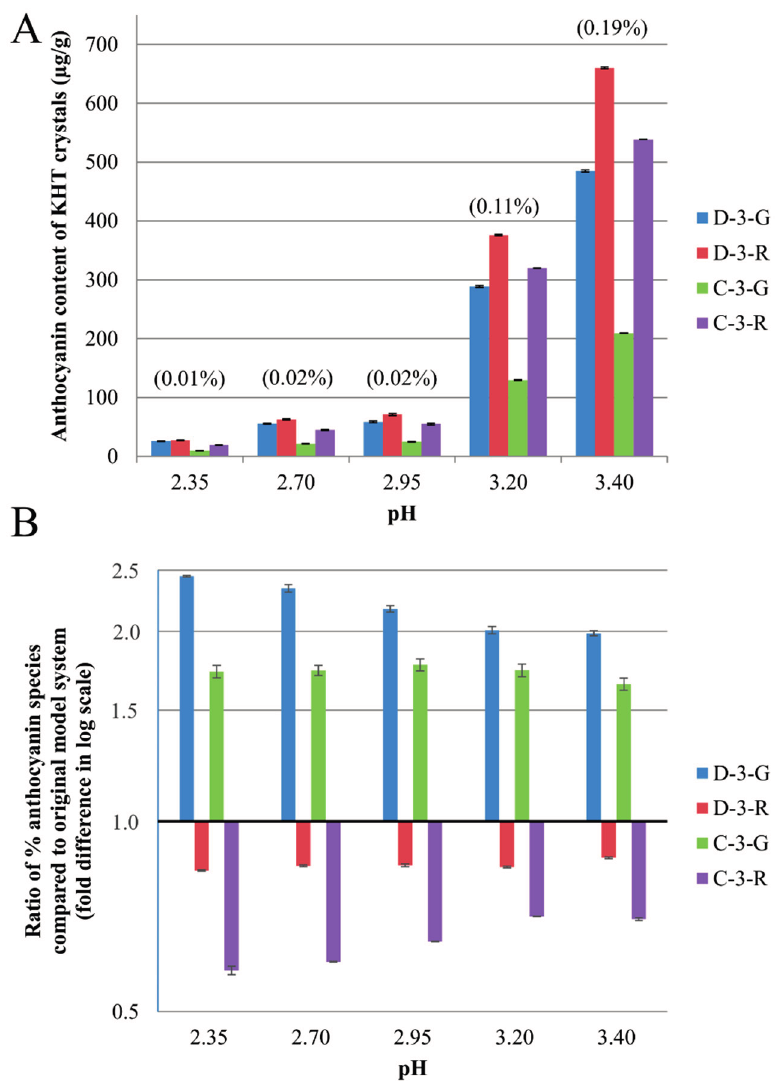
Figure 2. ( A ) Anthocyanin concentration ( μ g/g) in KHT crystals as a function of pH recovered from model juices containing 0.04 M tartaric acid and 0.04 M KCl. The number in parenthesis represented the total anthocyanin in KHT crystals (% w/w); ( B ) Selectivity of coprecipitation, calculated as the ratio of an anthocyanin species concentration in KHT crystals (normalized to total anthocyanin in KHT crystal) to the anthocyanin species concentration in original model juice (normalized to total anthocyanin in original juice). D-3-G: delphinidin-3-glucoside; D-3-R: delphinidin-3-rutinoside; C-3-G: cyanidin-3-glucoside; C-3-R: cyanidin-3-rutinoside. 2.2. Anthocyanin-Bitartrate Coprecipitation in a Purple Concord Grape